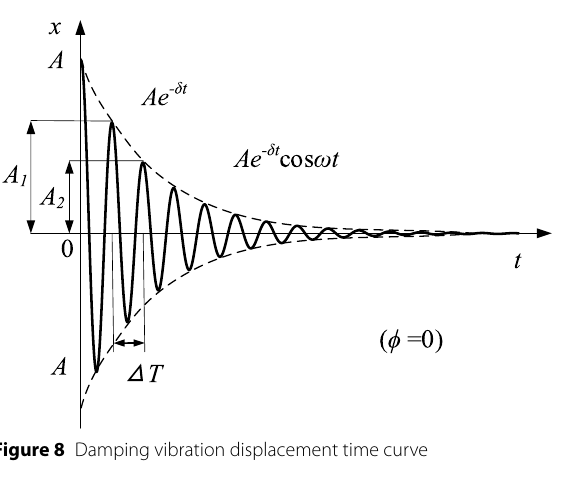
Figure 8 Damping vibration displacement time